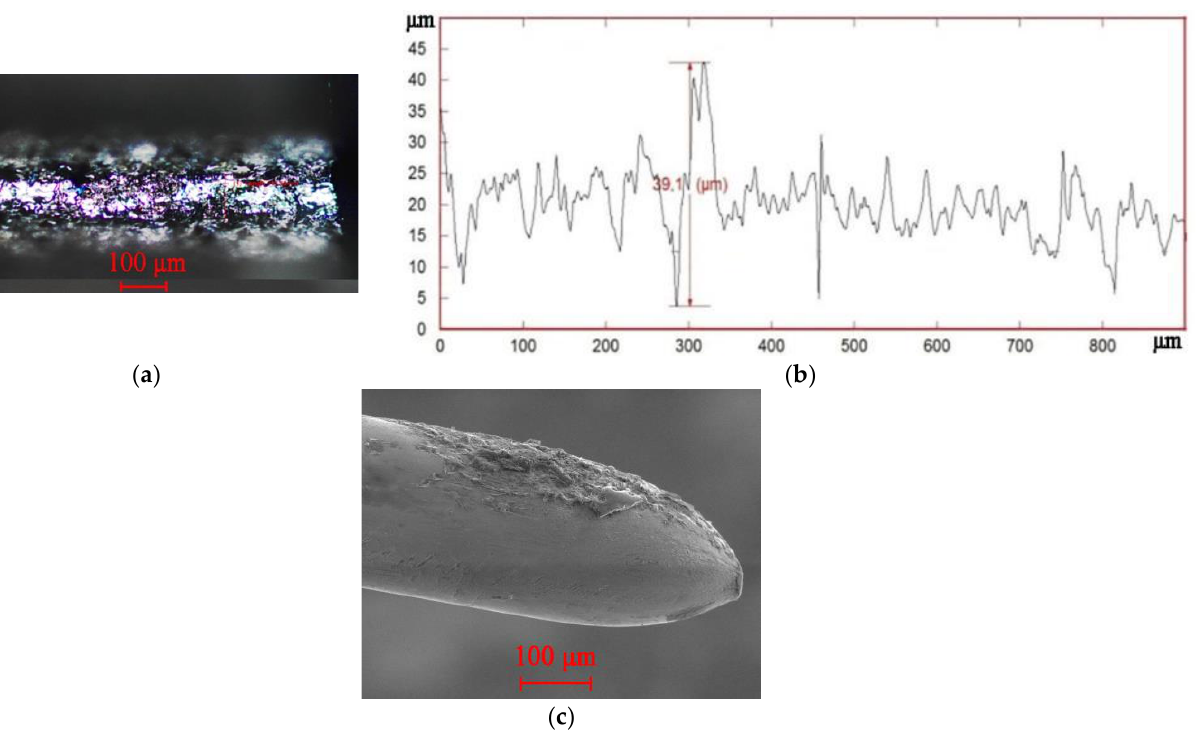
Figure 18. Surface characteristics after wire tool electrode breakage: ( a ) trace on the surface after breakage; ( b ) profilogram of the traces; ( c ) scanning electron microscopy of the wire tool electrode after breakage.